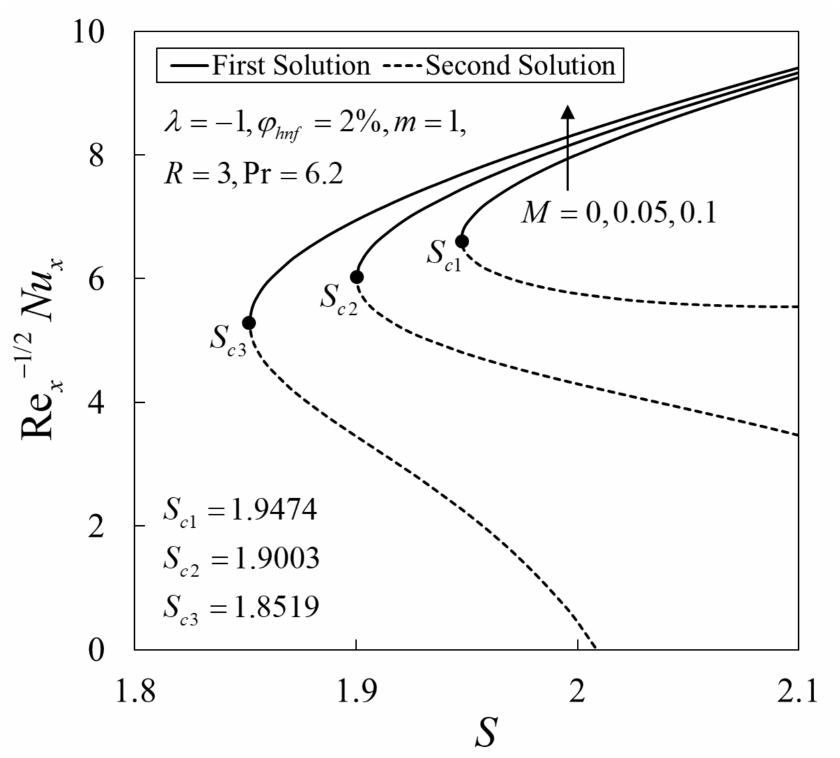
Figure 7. Variations of the local Nusselt number Re − 1/2 x Nu x against suction parameter S for different values of M